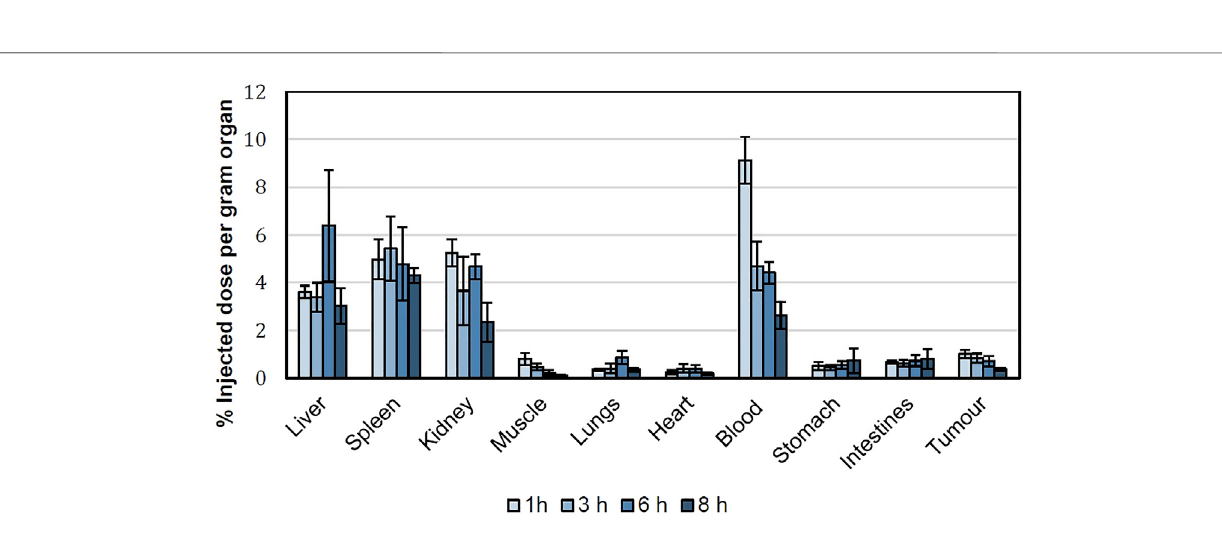
FIGURE 5 | Biodistribution of 99mTc-labeled niosomes in 4T1 tumor-beating female BALB/c mice expressed as %ID/g per organ.